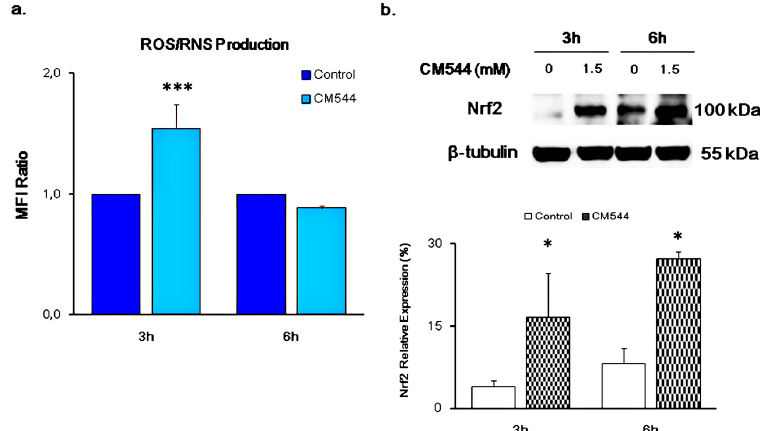
Figure 4. Generation of Reactive Oxygen/Nitrogen Species (ROS/RNS) and expression of Nrf-2 in C6 rat glioma cells in the presence of CM544. ( a ) Bars represent median values ( ± SD) calculated from individual histograms ( n = 3). Values are expressed as the MFI Ratio of the control (untreated cells). *** p < 0.001 treated vs. Control. ( b ) Representative protein bands of Nrf-2 obtained by Western blot analysis. β -tubulin expression is used as protein content marker. Results from one of three independent experiments are shown. Densitometric values are expressed as percentages of the integrated optical intensity of Nrf-2 bands normalized on β -tubulin. Nrf-2: nuclear factor (erythroid-derived 2)-like 2. * p < 0.05 treated vs. control (untreated cells).